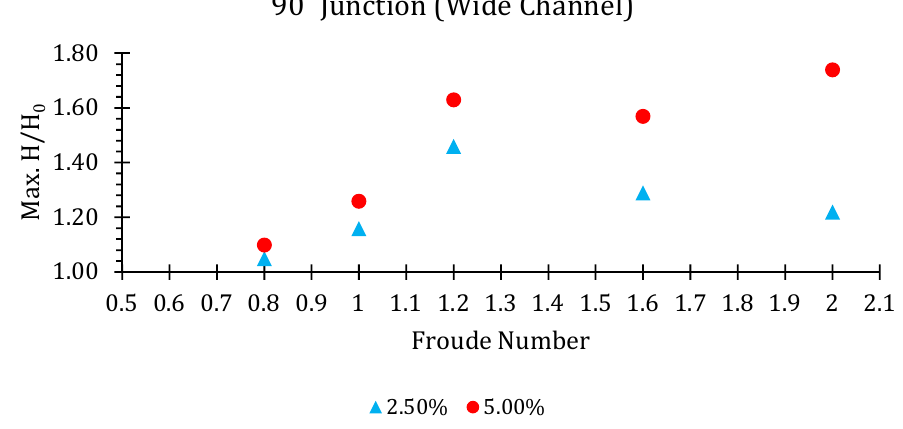
Figure 10. Maximum water height ratios in a 90° junction (wide channel).